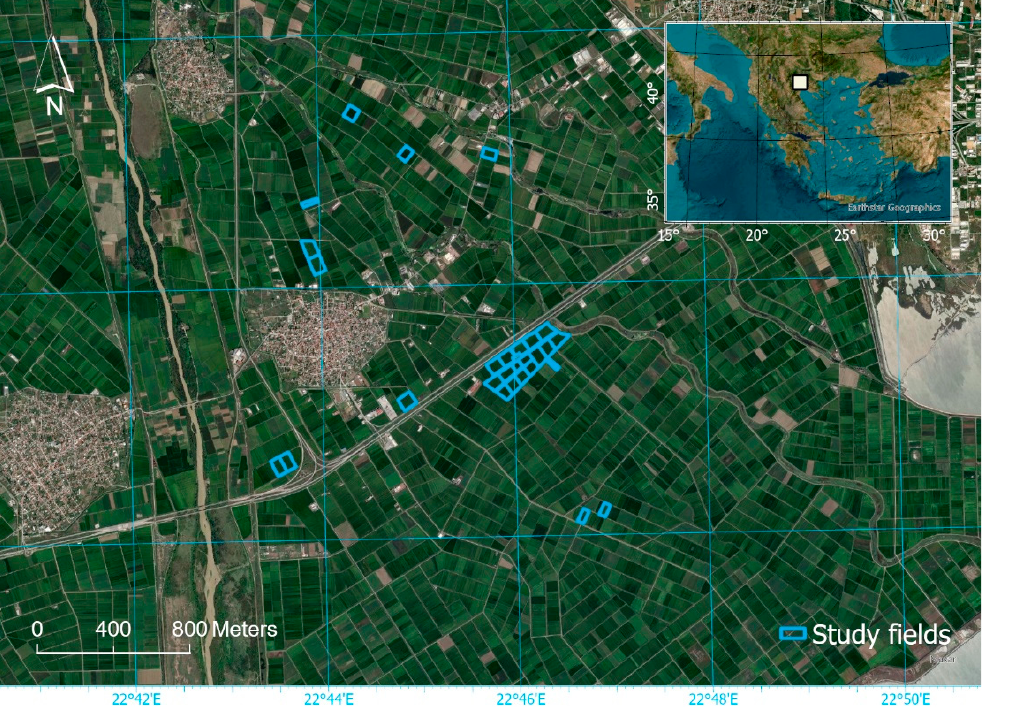
Figure 1. The study rice fields located in the Thessaloniki Plain, Greece.